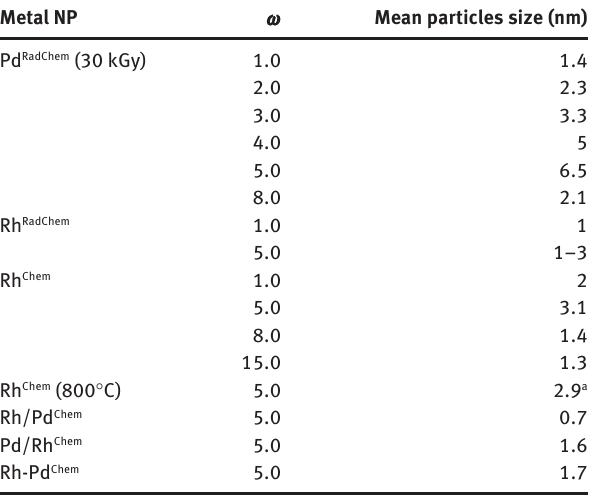
Table 1 Metal particle